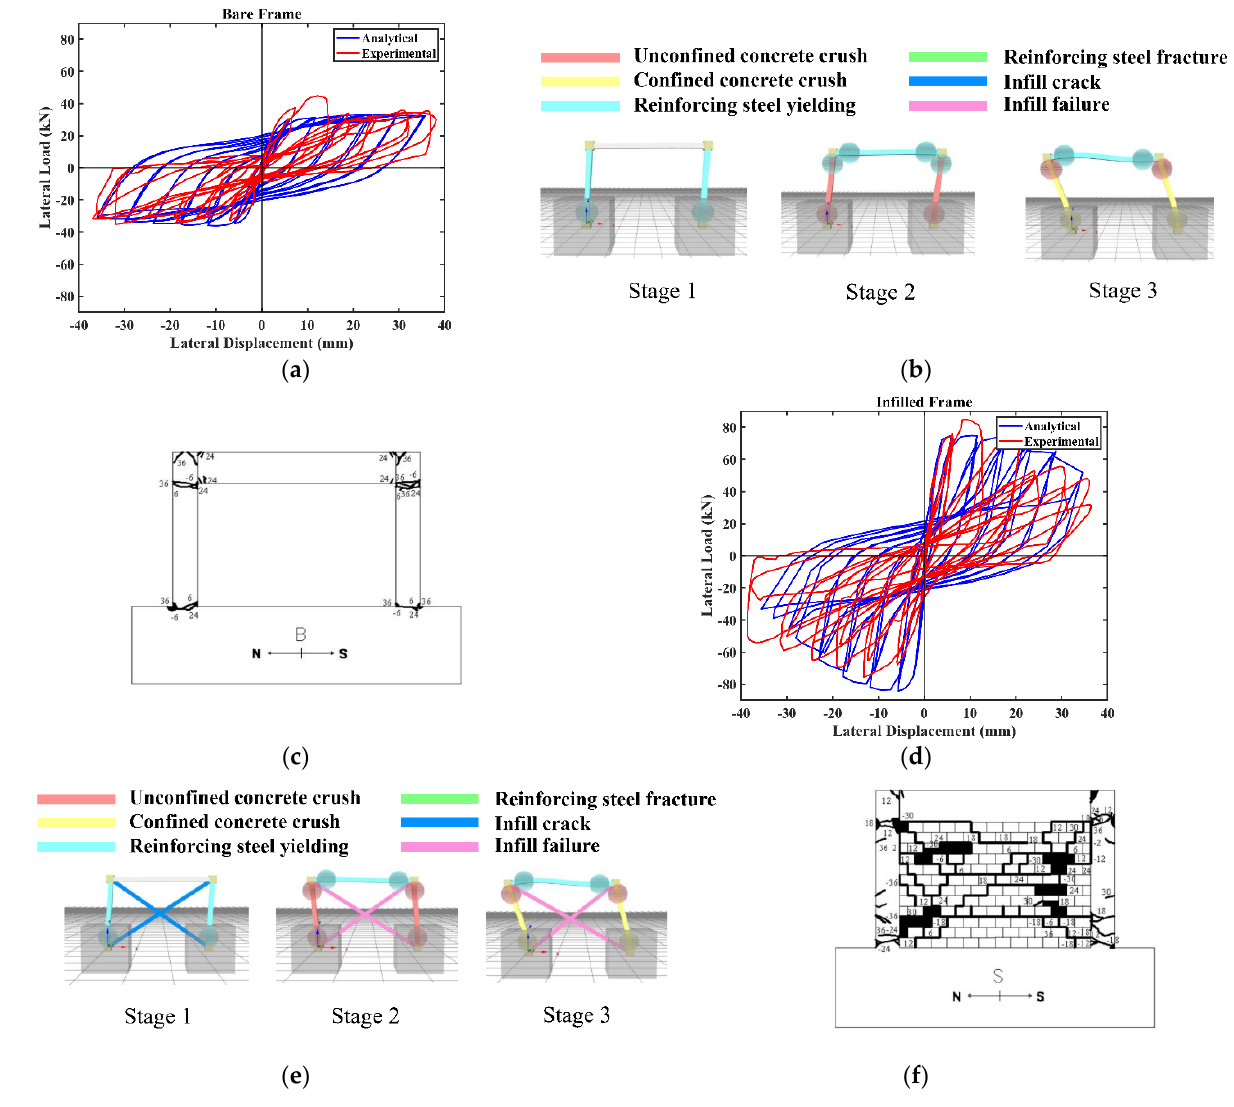
Figure 3. Comparison of analytical models in this study with experimental models [40]: ( a ) analytical and experimental results of the bare frame; ( b ) failure mechanisms of the bare frame based on the analytical model; ( c ) failure mechanisms of the bare frame based on the experimental model; ( d ) analytical and experimental results of the infilled frame; ( e ) failure mechanisms of the infilled frame based on the analytical model; ( f ) failure mechanisms of the infilled frame based on the experimental model.